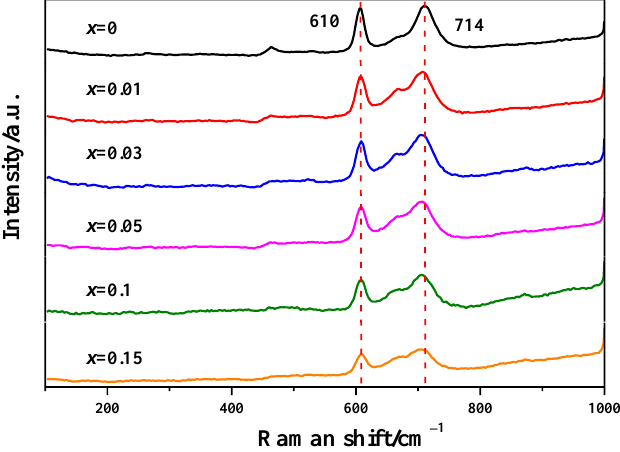
Figure 5. Raman spectra of the prepared ZGMSO:Cr 3+ ( x = 0 – 0.15) calcined at 1000 °C.